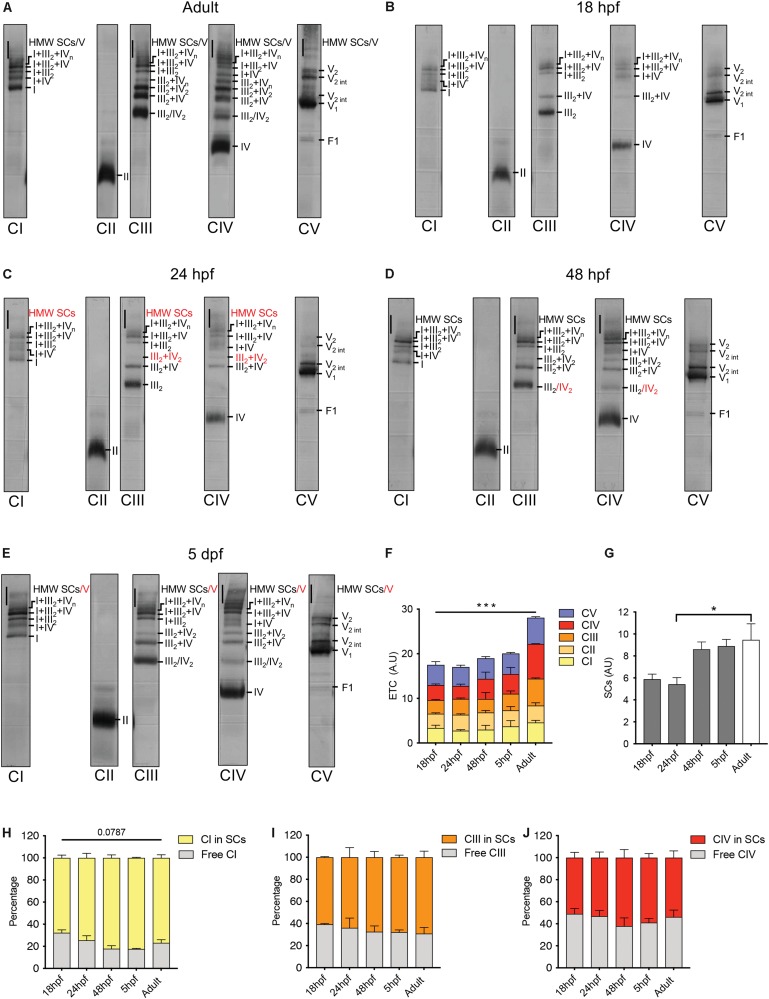
Electron transport chain supercomplexes are qualitatively stable throughout zebrafish development. (A–E) Representative BN-PAGE experiment with mitochondrial extracts from adult fish (6 months), 18, 24, 48 hpf, and 5 dpf. Specific antibodies against individual ETC complexes were used separately. Red numbers correspond to new bands appearing at particular time points. HMW is high molecular weight, int is intermediate. (F) Quantification of individual ETC complexes. Each value represents the signal on the immunoblot for each ETC complex (n = 2, each n with 250 embryos per group). (G) Quantification of supercomplexes (SCs). Each value represents the sum of all SCs bands including III2 + IV, III2 + IV2, I + III2, I + IV, I + III2 + IV, I + III2 + IVn and HMW SCs (n = 2, each n with 250 embryos per group). (H–J) Quantification of the percentage of CI, CIII, and CIV in free form and in SCs (n = 2, each n with 250 embryos per condition). Bars are mean ± SEM. ∗P < 0.05, ∗∗∗P < 0.001, two way repeated measures ANOVA (line is effect of time) or one way repeated measures ANOVA with Tukey HSD post hoc comparison (bracket). See also Supplementary Figure S6.